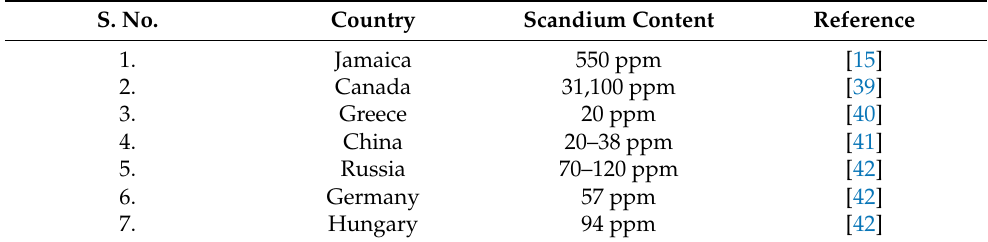
Table 2. List of countries reported to be generating bauxite ore in recent years and the scandium content of the